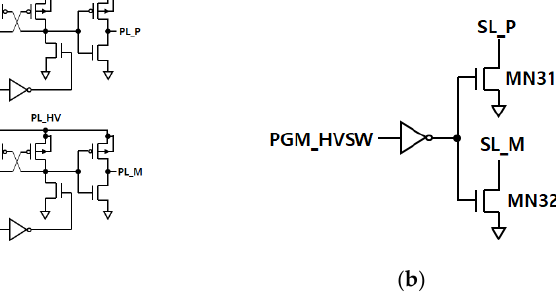
Figure 11. ( a ) PL driving circuit; ( b ) SL driving circuit.